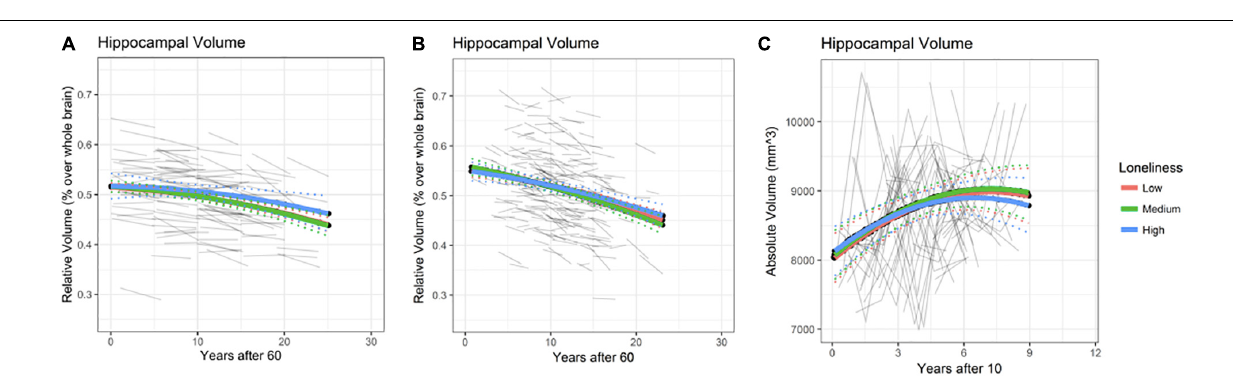
FIGURE 3 | Hippocampal (HPC) volume predicted trajectories versus age after 60 for different loneliness levels for BETULA (A) and BASE-II (B) . (C) Depicts hippocampal trajectories for the younger participants (HUBU cohort) from age 10 onwards, as regards the loneliness variable. Raw hippocampal volumes are shown for HUBU, as absolute values might be more convenient in longitudinal studies of brain development (Goddings et al., 2014). Dotted lines show 95% confidence interval for predictions with random effects set to